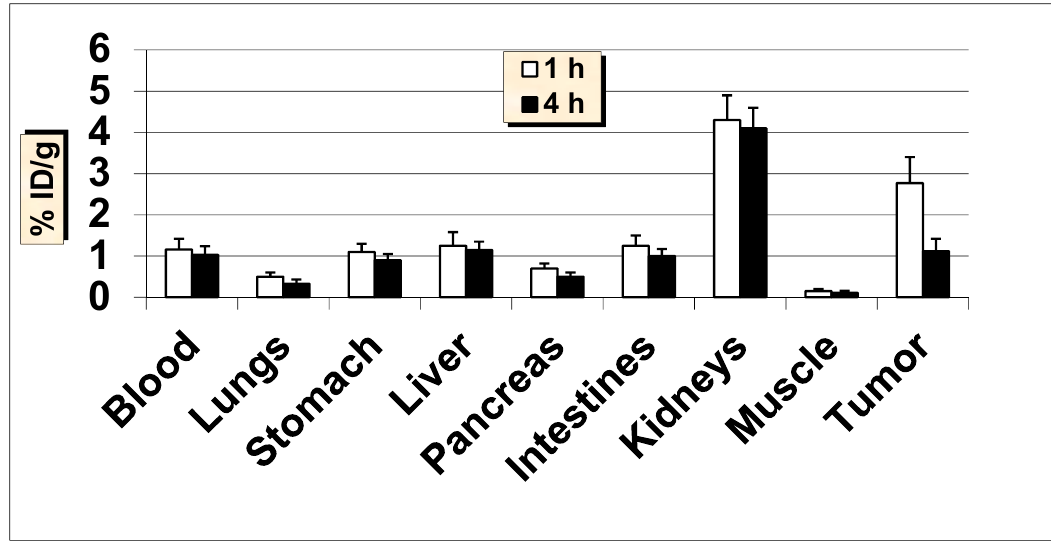
Figure 12. In vivo tumor targeting of 99m Tc-MUC1-derived peptide in MUC1-positive MCF7 tumor bearing female nude mice at 1 and 4 h post-injection. Data are expressed as % injected dose per gram (% ID/g) of tissue/organ (n = 3, mean values ± SD). Parts of the intestines were measured without their